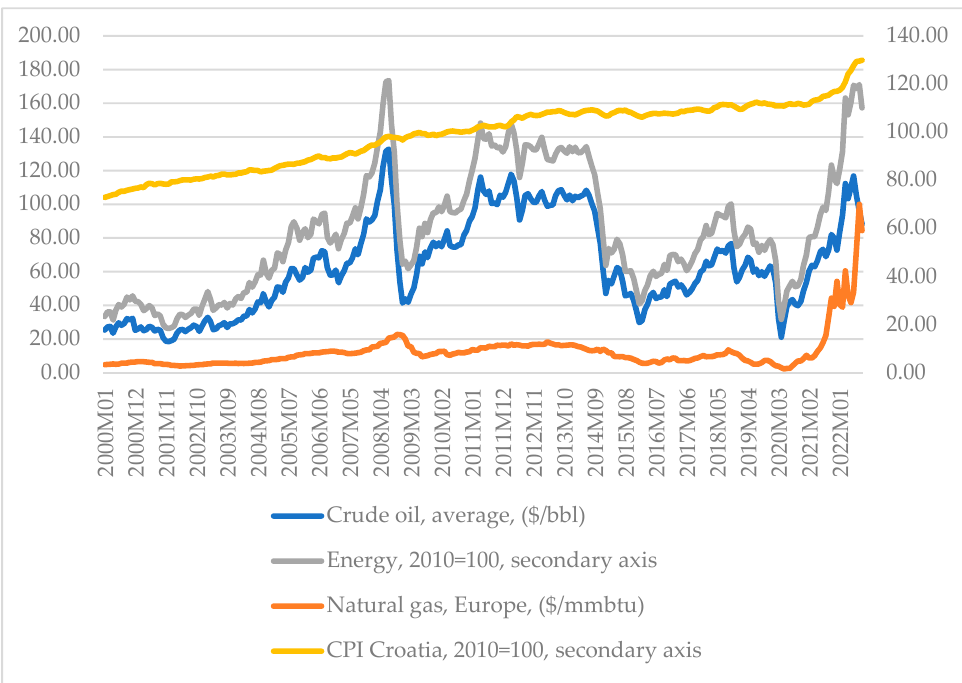
Figure 1. Long-term trends in energy prices and inflation in Croatia. Source: https://www.worldbank.org/en/research/commodity-markets (accessed on 23 October 2022).